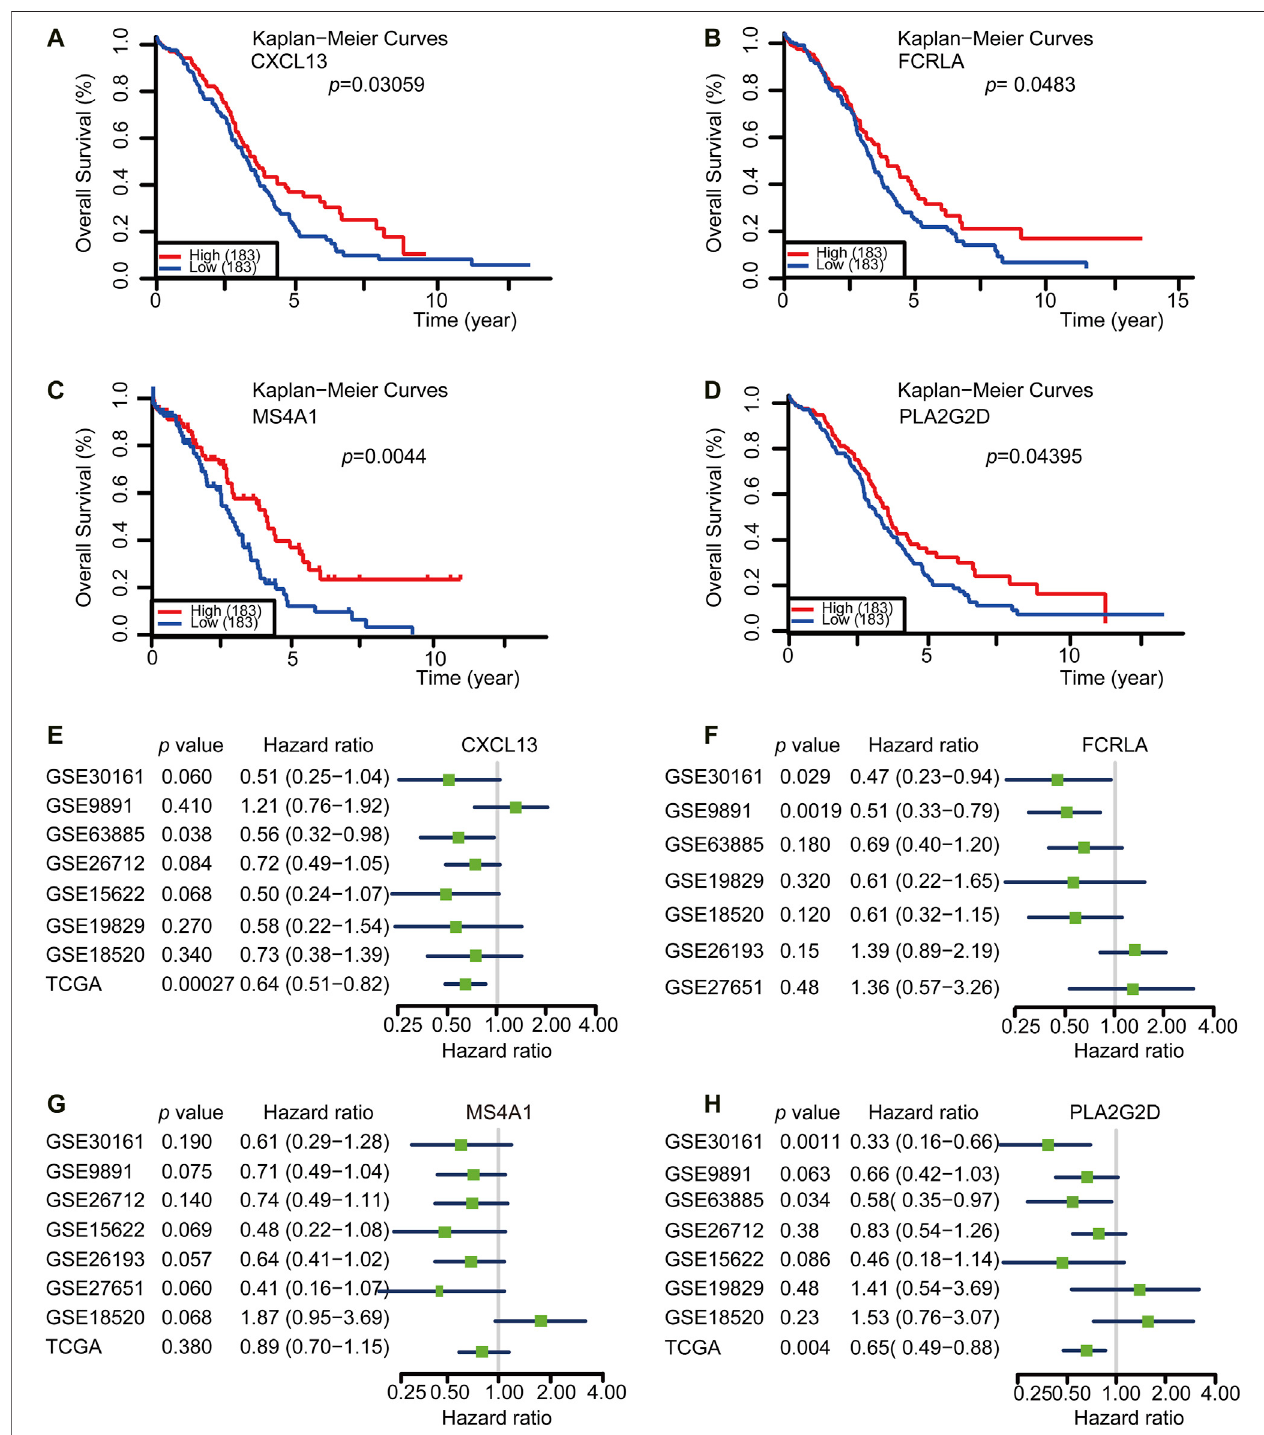
FIGURE 4 | CXCL13, FCRLA, MS4A1, and PLA2G2D were correlated with a good prognosis of OC. (A – D) Kaplan-Meier curves for overall survival probability in 366 OC patients with low ( n (cid:1) 183) and high (183) CXCL13, FCRLA, MS4A1, and PLA2G2D expression (analyzed with log-rank test, p < 0.05). (E – H) Meta-analysis describing forest plots of CXCL13, FCRLA, MS4A1, and PLA2G2D expression as a univariate predictor of overall survival.